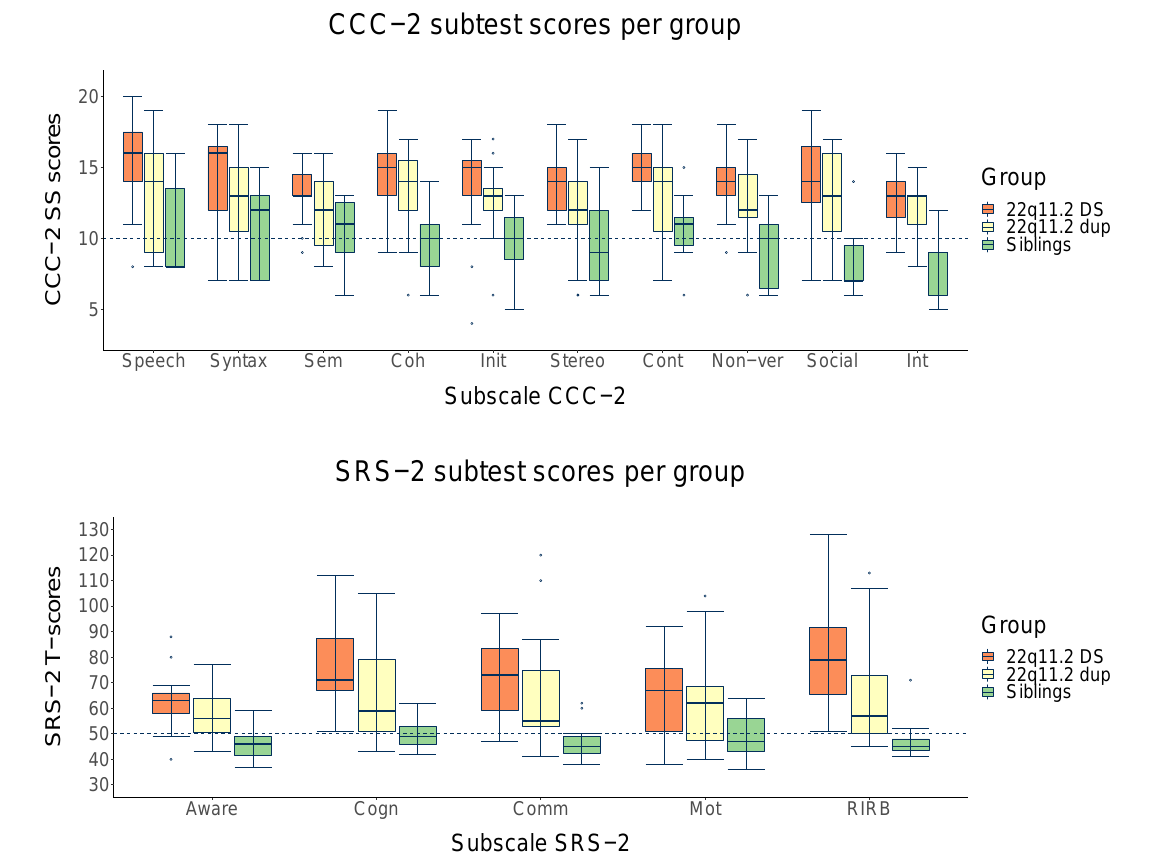
Figure 2. Boxplots for CCC-2 (M = 10, SD = 3) and SRS-2 (M = 50, SD = 10) group scores across subtests. The dashed lines show norm group averages. The gray zones indicate the severity of the